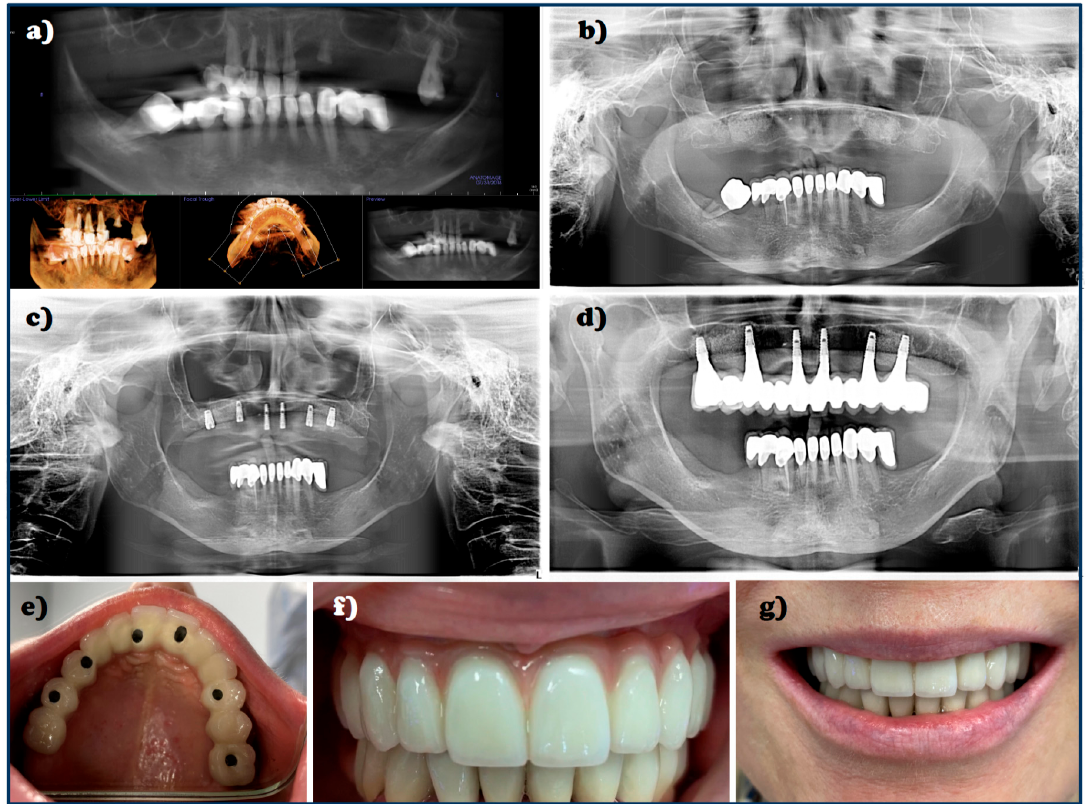
Figure 18. An example of an implant-prosthetics treatment of the female patient with 3-degree unstable (MOB = 3) prosthetic restoration of the 12–24 segment due to periodontal disease. ( a – d ) The pantographic X-ray images: ( a ) revealing significant bone loss; ( b ) after tooth extraction from periodontal diseases reasons; ( c ) after the insertion of the implants using a surgical template; ( d ) after installing the finished prosthetic restoration; ( e – g ) view of the prosthetic restoration: ( e ) in the oral cavity; ( f ) full-arch prosthetic bridge; g) the patient’s full smile after treatment.